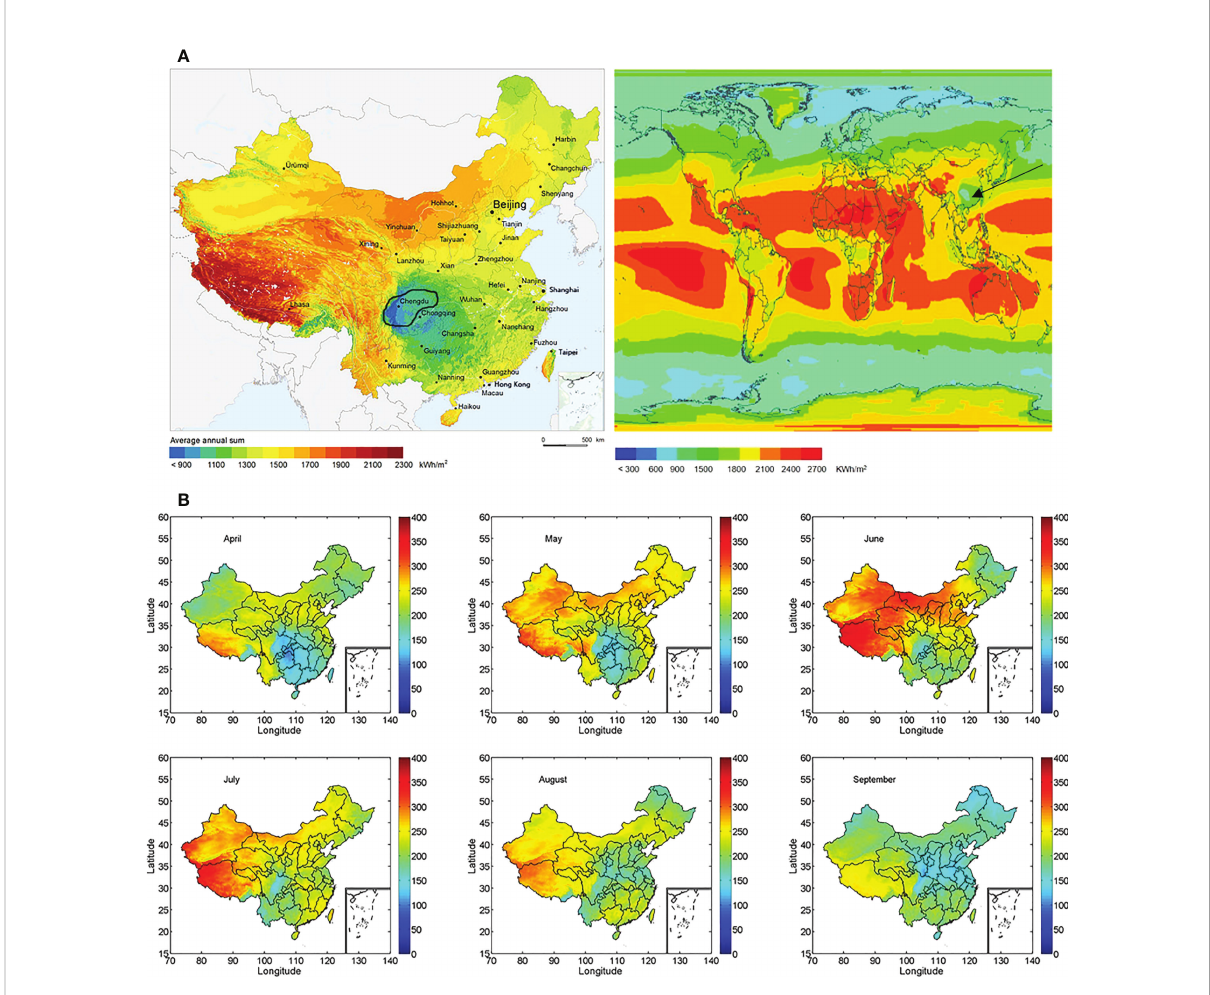
FIGURE 1 Solar radiation in various regions of China (2021 Copyright Sun Reign Ltd). (A) : The black circle indicates Sichuan province. Southwest China (includes the Sichuan, Yunnan, Guizhou provinces, and Chongqing city) are lower solar radiation than surrounding countries. (B) : Solar radiation during the maize growth period, the unit of solar radiation is W m -2